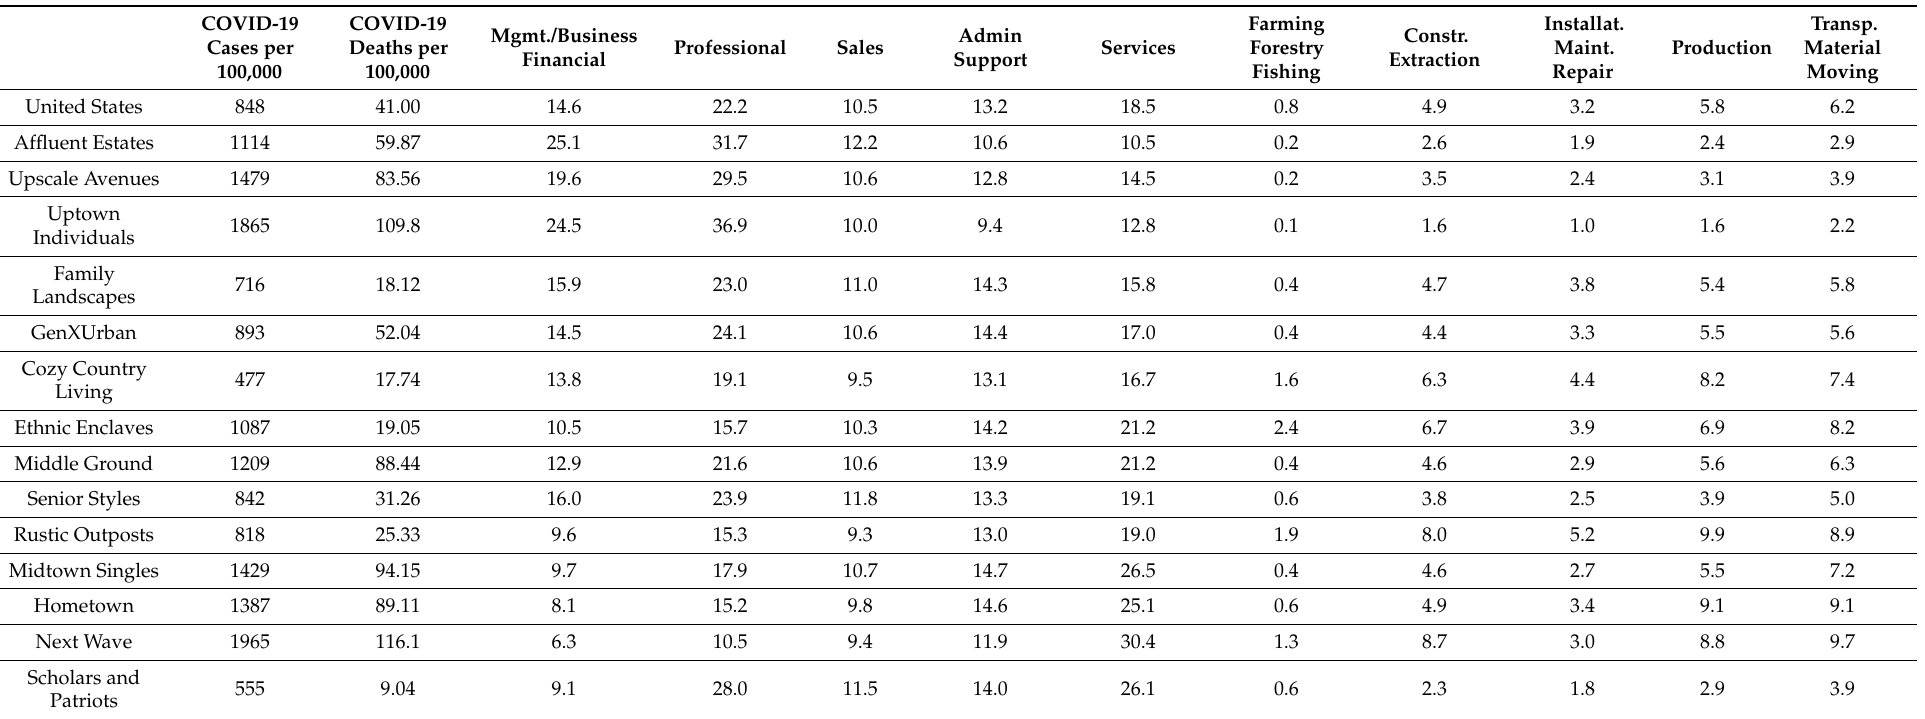
Table 6. Employment by occupation